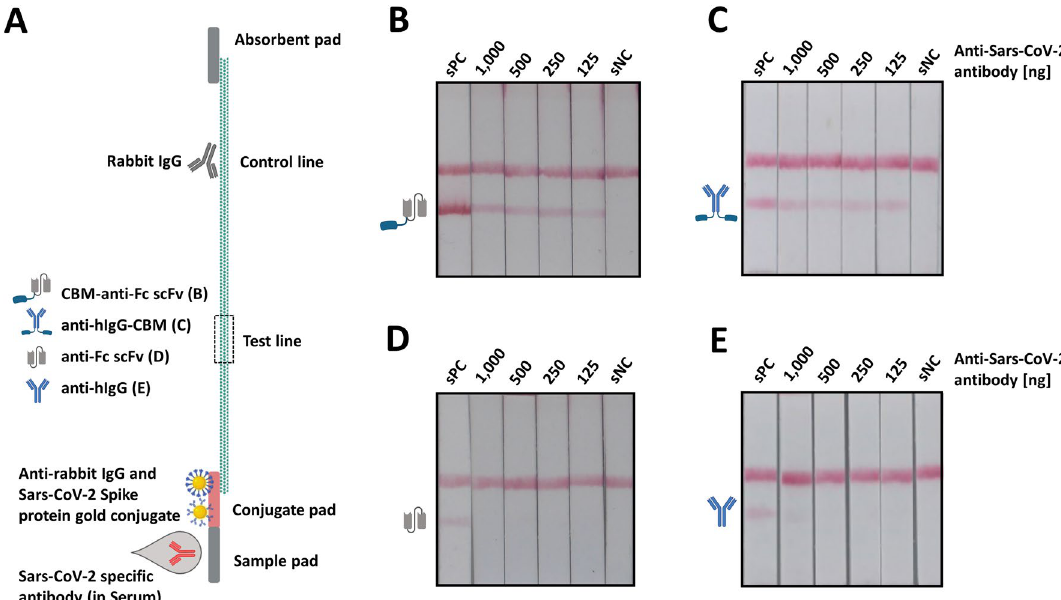
Figure 5. Cellulose-based lateral flow assays for the detection of SARS-CoV-2 specific antibodies in serum samples. ( A ) Experimental setup for the Covid19 antibody LFA using ( B ) CBM-anti-Fc scFv, ( C ) anti-hIgG- CBM, ( D ) anti-Fc scFv or ( E ) anti-hIgG functioning as detection antibody, printed on the test line area. 150 µl of sample was applied to the sample pad, containing 130 µl of TBS buffer,20 µl of human serum and different amounts of anti-SARS-CoV-2 spike antibody. Sample compositions are listed in Table